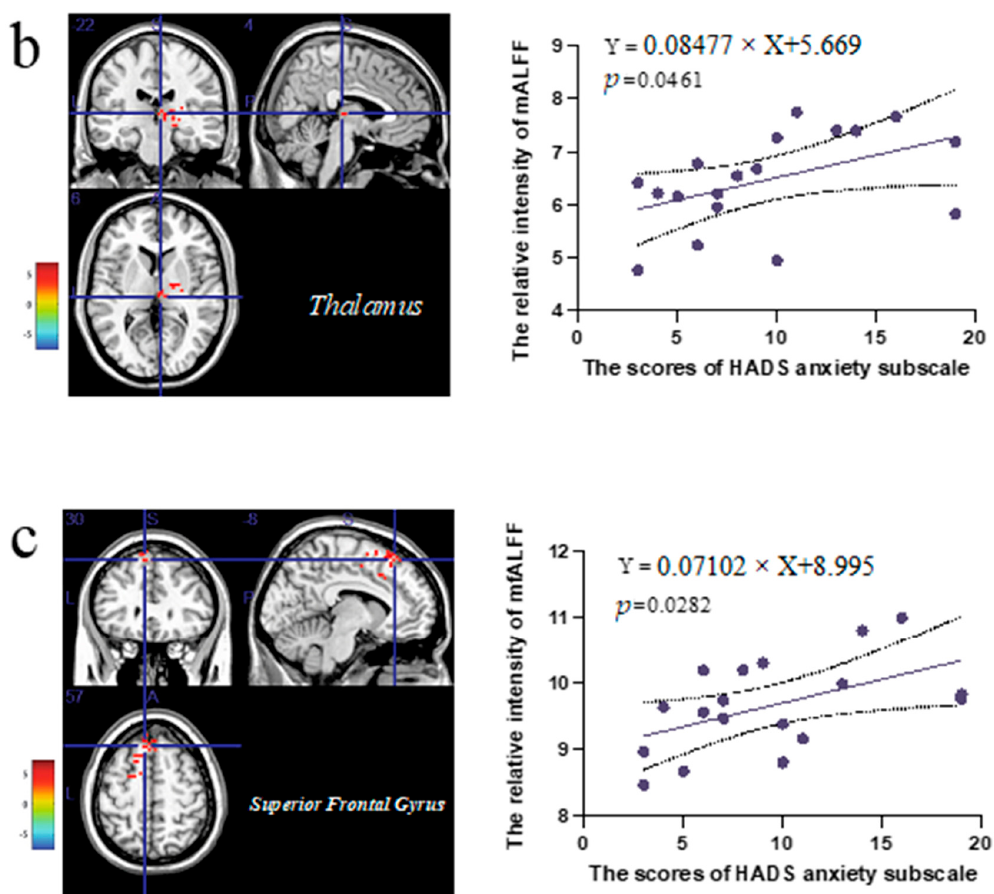
Figure 3. The Outcomes of Correlation Analysis among ROIs and Clinical Scale Scores. ( a ) The correlation between the scores of NRS and mALFF values in PAG ( r = 0.2712, p = 0.0019, R 2 = 0.4620). ( b ) The correlation between the scores of HADS anxiety subscale and mALFF values in thalamus ( r = 0.08477, p = 0.0461, R 2 = 0.2261). ( c ) The correlation between the scores of HADS anxiety subscale and mfALFF values in superior frontal gyrus ( r = 0.07102, p = 0.0282, R 2 = 0.2667). There was no correlation between the relative values of mALFF and mALFF in the other ROIs and the scores of clinical scales. ROIs: regions of interest, NRS: Numeric Rating Scale, mALFF: mean amplitude of low-frequency fluctuation, PAG: periaqueductal gray matter, HADS: Hospital Anxiety and Depression Scale, mfALFF: mean fractional amplitude of low-frequency fluctuation.